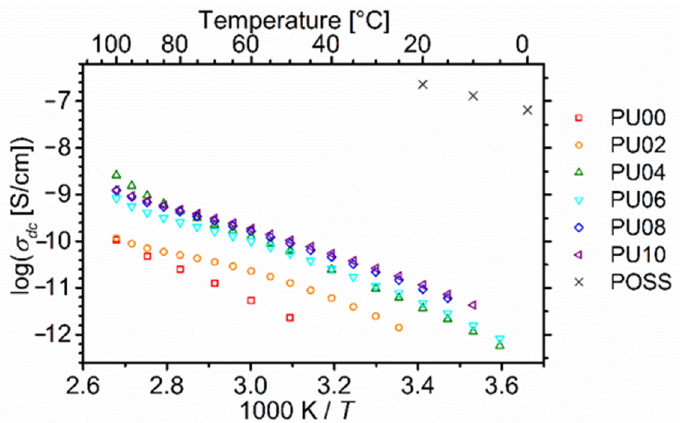
Figure 15. Arrhenius plot (activation map) of dc conductivity for all materials under investigation. A few points for PEG-POSS have been included for comparison. Data for POSS are based on re-analysis of data published in [32].